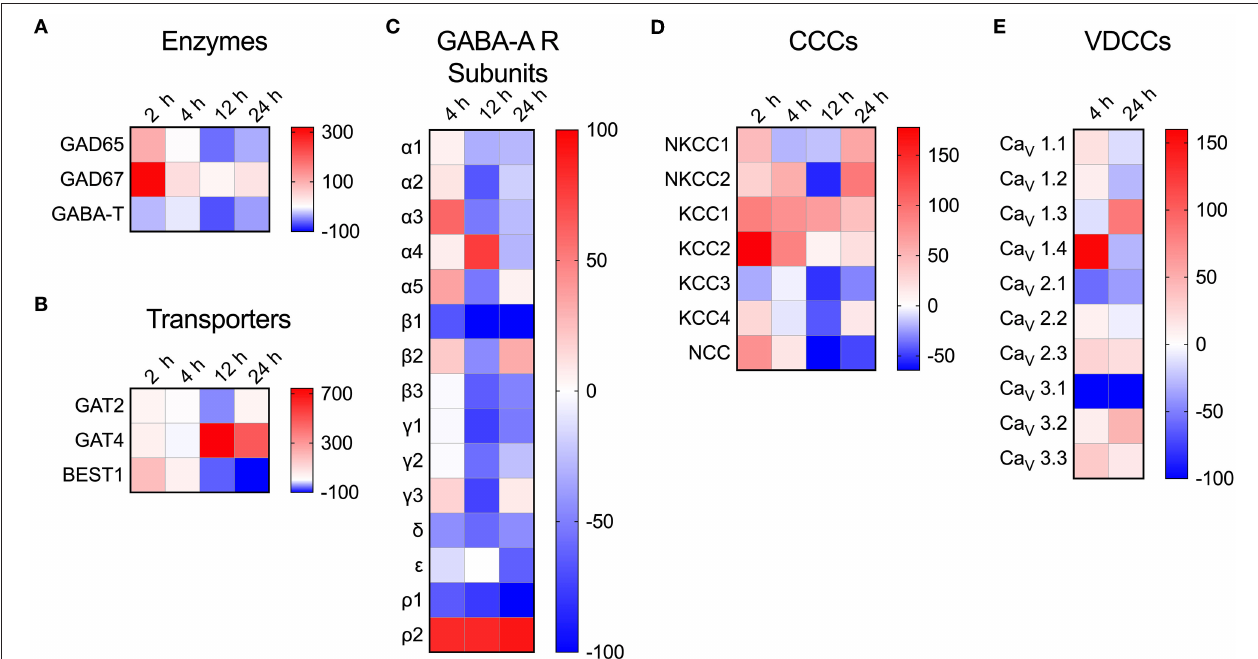
FIGURE 4 | Modulated transcriptional expression of GABAergic and VDCC signaling components in Toxoplasma -challenged primary microglia. The relative expression (2 − 1 Ct ) for each target gene in Toxoplasma (PTG)-challenged primary microglia was normalized to that of in unchallenged microglia and the differences are represented as percentage increase (red color intensity scale) or decrease (blue scale) in the heat map. For both conditions, unchallenged and Toxoplasma -challenged, data is represented as mean of 2–4 independent experiments at indicated time points. The modulation of mRNA expression is shown for (A) GABA synthesis and degrading enzymes, (B) GABA transporters, (C) GABA-A R subunits, (D) CCCs, and (E)